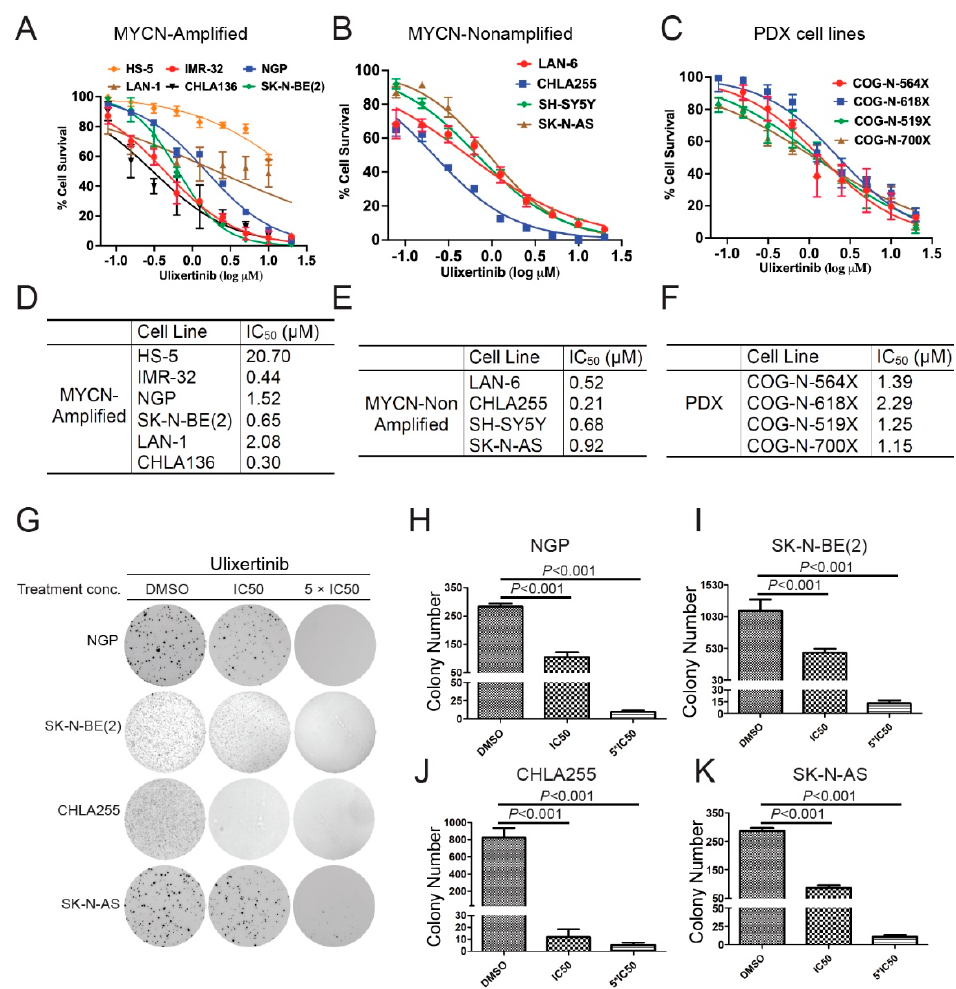
Figure 1. Ulixertinib inhibits NB cell proliferation and anchorage-independent growth in vitro. ( A ) Five MYCN amplified NB cell lines (IMR-32, NGP, SK-N-BE(2), LAN-1, and CHLA136) and a noncancerous bone marrow stromal fibroblast cell line, HS-5, were treated with the indicated concentrations of ulixertinib for 5 days. Cell proliferation was measured by CCK-8 assays. ( B , C ) Four MYNC- non-amplified NB cell lines (LAN-6, CHLA255, SH-SY5Y, and SK-N-AS) ( B ) and four PDX cell lines (COG-N-519x, COG-N-564x, COG-N-618x, and COG-N-700x) ( C ) were also treated with unlixertinib as in (A). Cell proliferation was measured by CCK-8 assays. ( D – F ) IC50 values were calculated based on the data collected in the CCK-8 assay from ( A – C ). ( G ) The effects of ulixertinib on anchorage-independent cell proliferation. Four NB cell lines (NGP, SK-N-BE(2), CHLA255, and SK-N-AS) were grown in soft agar with DMSO, 1 × IC50, and 5 × IC50 of ulixertinib for 4 weeks. Cells were stained with 0.5% ( w/v ) MTT solution to visualize colonies and photographed. ( H – K ) Colonies from ( G ) were counted in NGP ( H ), SK-N-BE(2) ( I ), CHLA255 ( J ), and SK-N-AS ( K ) cells. Colony numbers were represented as mean ± S.D. A two-tailed Student’s t- test was used to determine the statistical significance.